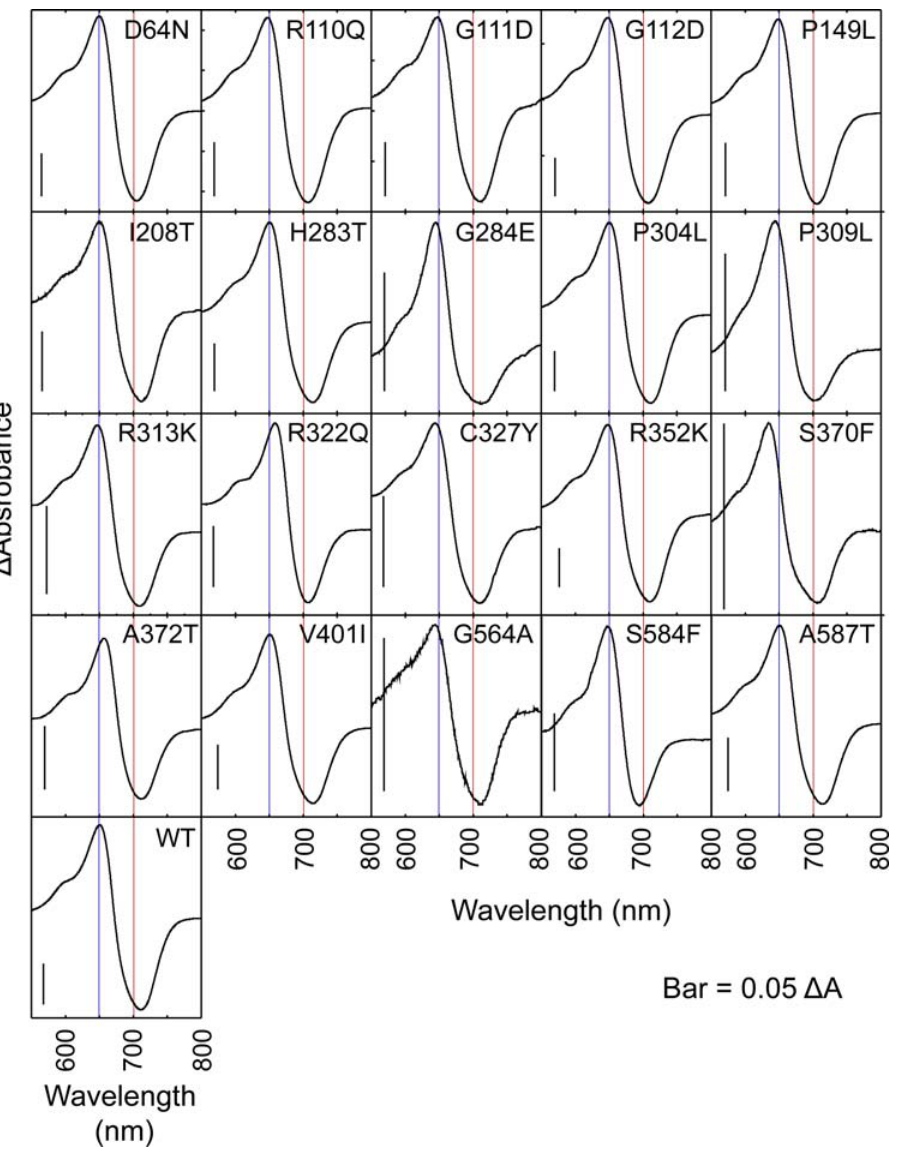
Figure 3. Pr-Pfr Difference Spectra of Mutant N651 Fragments. The mutated holoproteins were prepared as for Figure 2 and subjected to spectrophotometry. Blue and red lines indicate 650 and 700 nm, respectively.